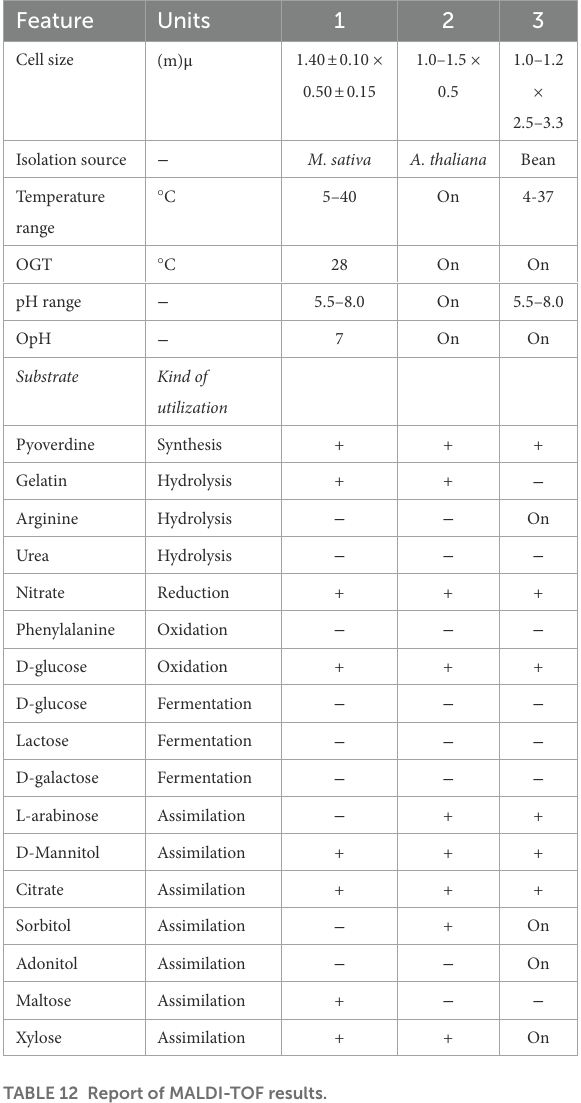
TABLE 11 Differential characteristic phenotype of Pseudomonas agronomica sp. nov. and closely related Pseudomonas spp.